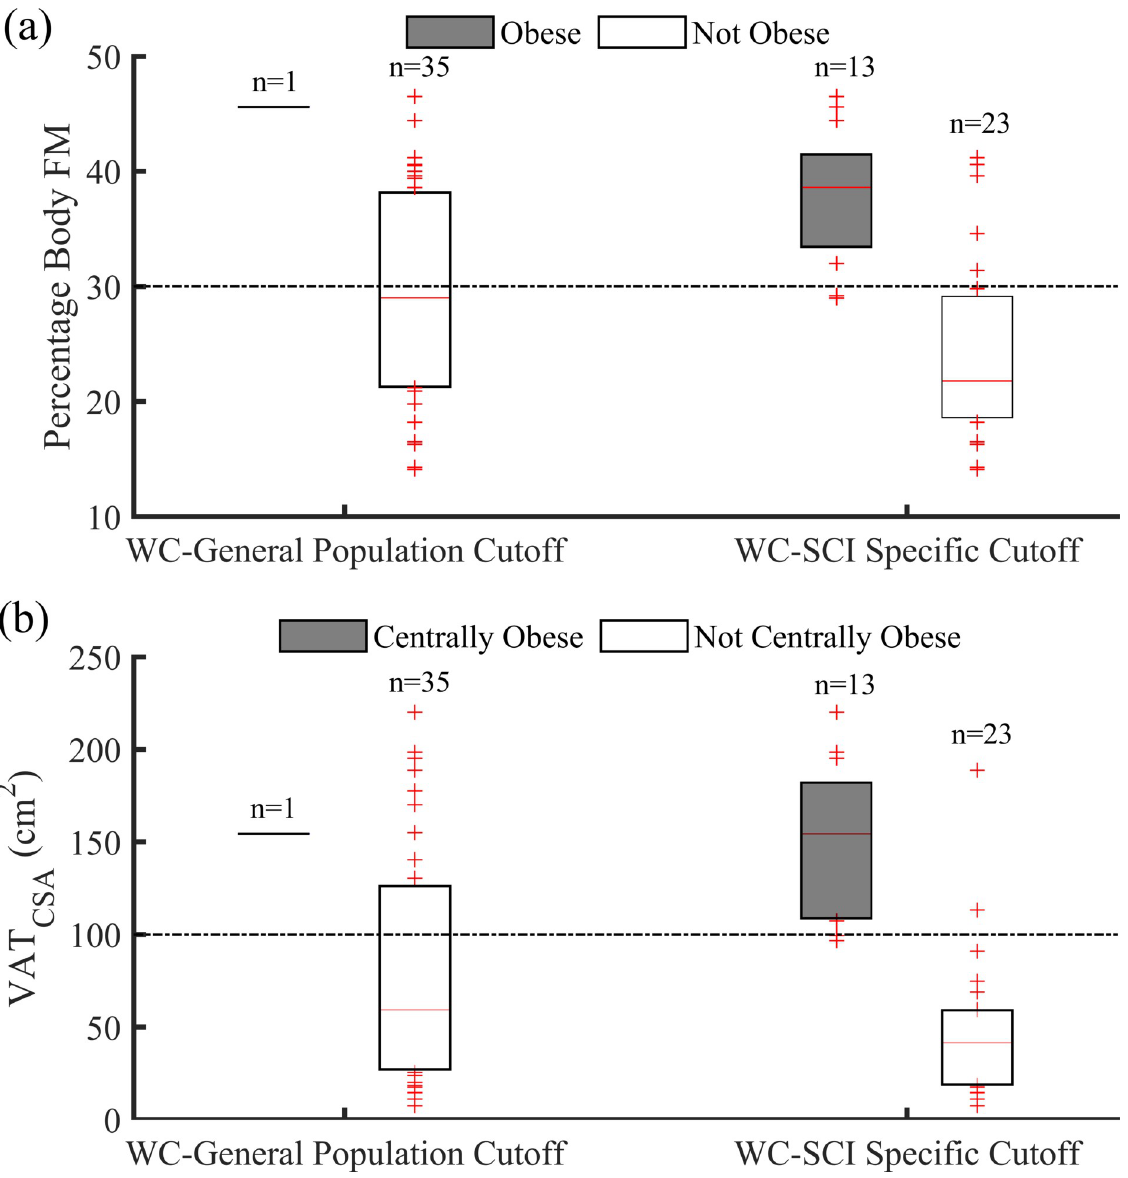
Fig 1. (a): Distribution of percentage body fat mass for participants classified as “obese” and “not obese” using general population (102 cm) and SCI specific (86.5 cm) cutoff points for WC. (b): Distribution of visceral adipose tissue cross-sectional area for participants classified as “centrally obese” and “not centrally obese” using general population (102 cm) and SCI specific (86.5 cm) cutoff points for WC. Data are presented using box plots. The optimal cutoff points (percentage body fat mass of 30% and visceral adipose tissue cross-sectional area of 100 cm 2 ) are represented using black dotted